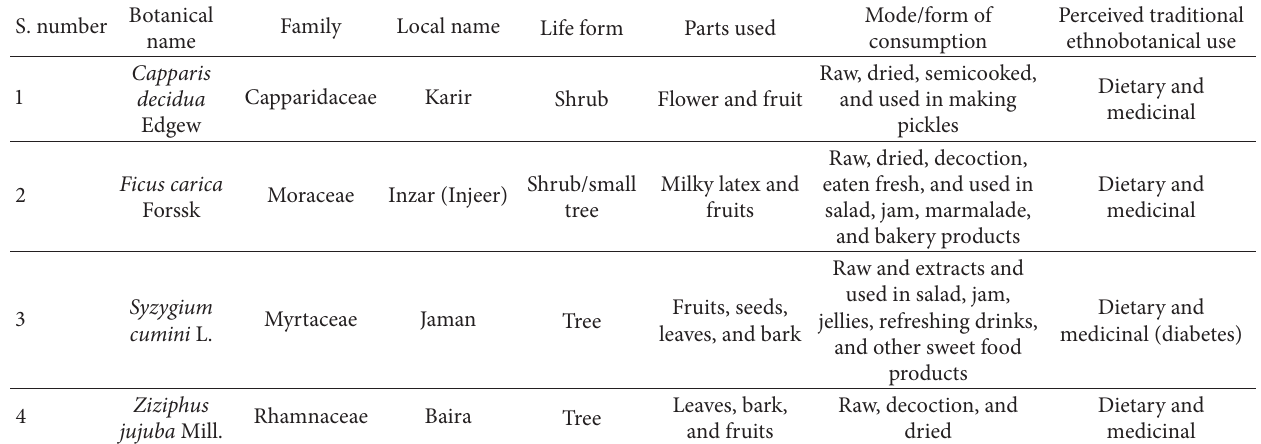
Table 1: Ethnobotanical information of selected species of subject area used as food and